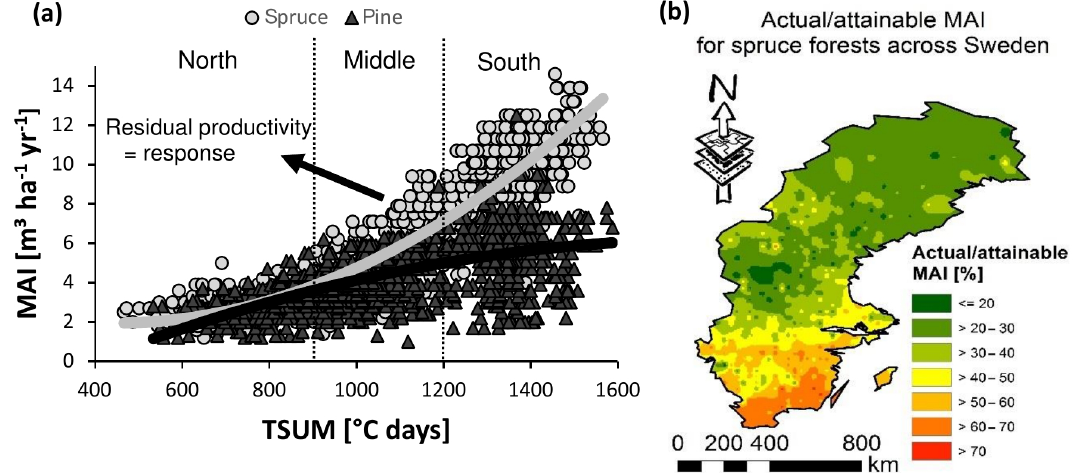
Figure 3. Normalized productivity was calculated in two alternative ways. (a) In method 1, residual values were taken from a regression model, explaining variation in mean annual increments (MAIs) by climate (growing season temperature sum or TSUM and precipitation) and species. The selection procedure, equation, and parameter estimates are given in the Supplement (respectively Tables S1 and S2 and Eq. S1 in the Supplement). In order to avoid heteroscedasticity-induced artifacts, the dataset was split into northern (TSUM<900 ◦ C days), middle (900 ◦ C days<TSUM <1200 ◦ C days), and southern (TSUM>1200 ◦ C days) regions for this approach. (b) In method 2, actual productivities for spruce were divided by theoretically attainable productivities, provided by Bergh et al.